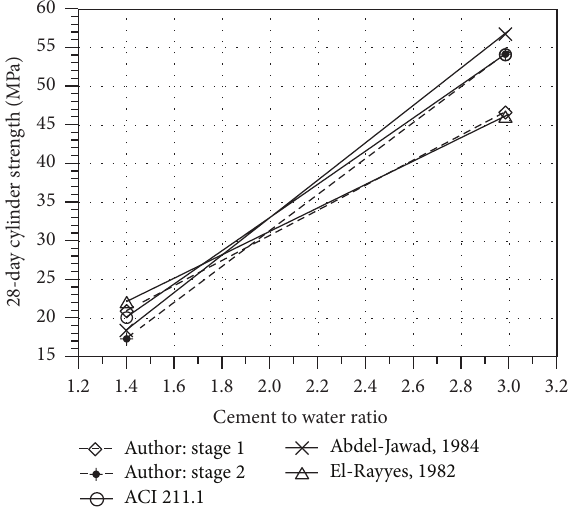
Figure 5: Comparison of the relationship between c / w ratio and strength of concrete in